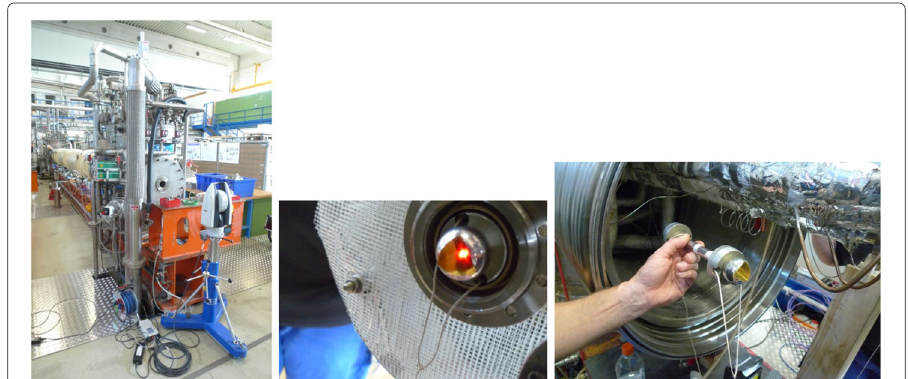
Fig. 14 The laser tracker to measure the position of a reflector in the vacuum pipe of the dipole through an open flange in the end box. Middle: Mouse with attached reflector inserted into the beam pipe; Right: Before insertion. The string connected to the mouse is used to pull it through the beam pipe